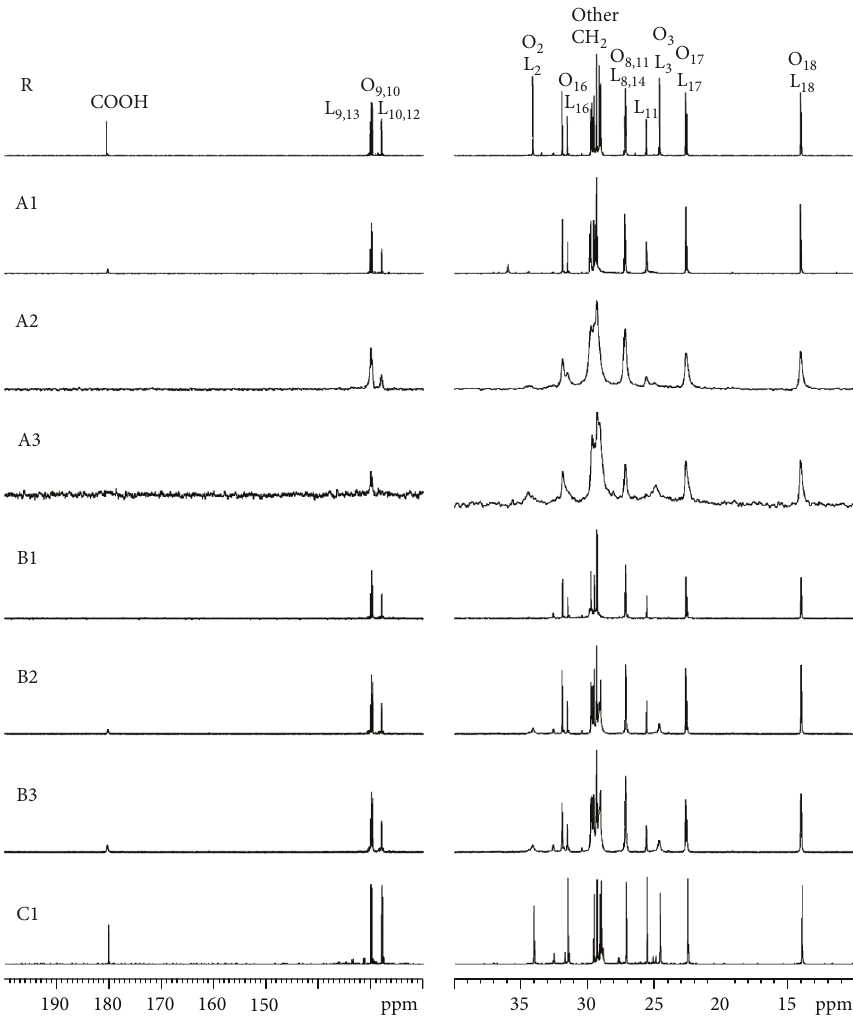
Figure 2: 13 C NMR spectra of the products obtained from a fatty acid/iron/carbon dioxide/water